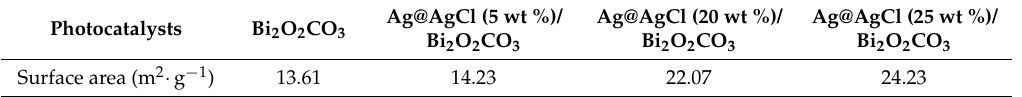
Table 1. Specific surface area of Ag@AgCl/Bi 2 WO 6 composite catalysts.